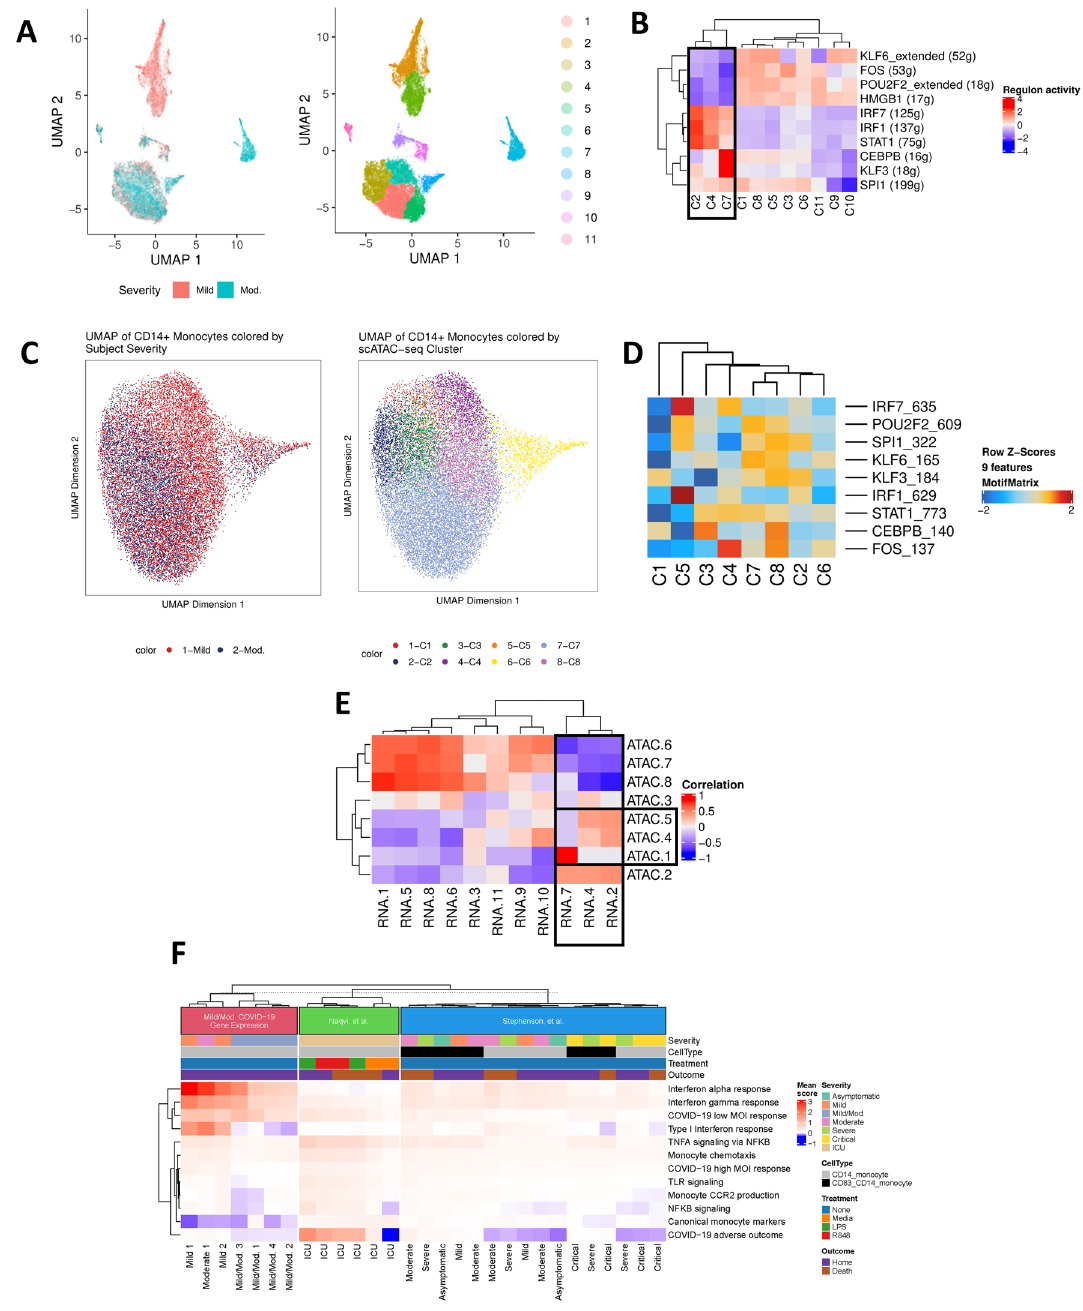
Figure 5. CD14+ monocytes undergo extensive chromatin remodeling prior to seroconversion and harbor severity-specific epigenetic biomarkers. ( A ) scRNA-seq UMAP of all CD14+ monocytes collected from mild and moderate IgG− subjects. UMAP colored by disease severity (left) and cluster number (right). ( B ) Heat map depiction of regulon activity computed for each scRNA-seq cluster using SCENIC. Activity of the top 10 regulons (right) is plotted for each cluster of cells from the UMAP (bottom). The black box indicates clusters of interest. ( C ) scATAC-seq UMAP of all CD14+ monocytes collected from IgG− mild and moderate subjects. UMAP colored by disease severity (left) and cluster number (right). ( D ) Heat map depiction of transcription factor motif enrichment of identified regulons (right) plotted for each scATAC-seq cluster (bottom). ( E ) Correlation plot using regulon activity to link clusters between scRNA-seq (columns) and scATAC-seq (rows). Black box indicates clusters of interest. ( F ) Enrichment of gene expression in monocyte-related pathways for CD14+ monocyte subsets from IgG− mild and moderate subjects. Pathway scores were computed for cell subsets from two published datasets for comparison. Hierarchical clustering was applied to samples within each